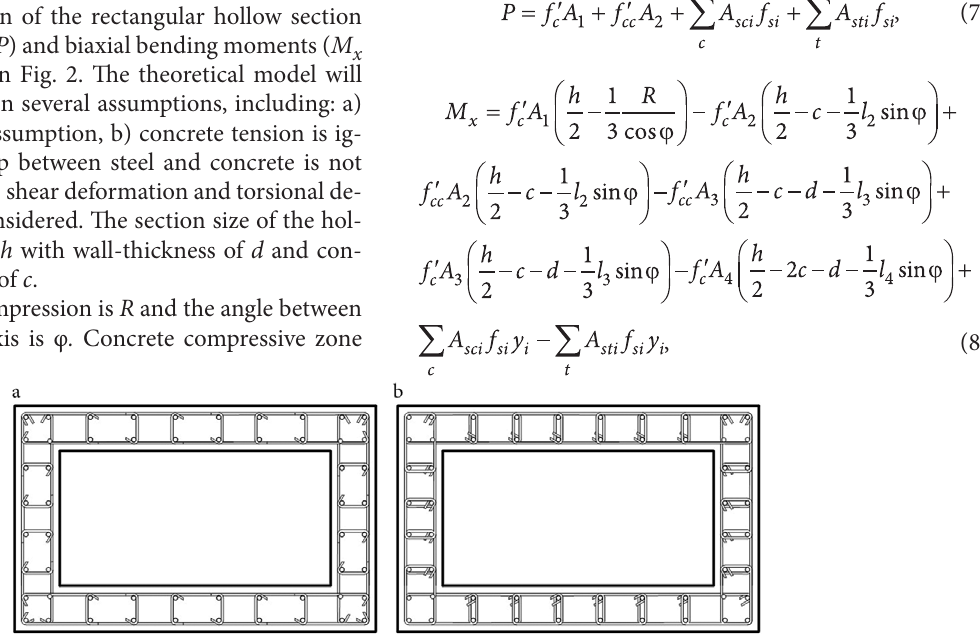
Fig. 1. Configurations of lateral reinforcement of RHS (Han et al . 2013): a – practice in China; b – suggested by JTG/T